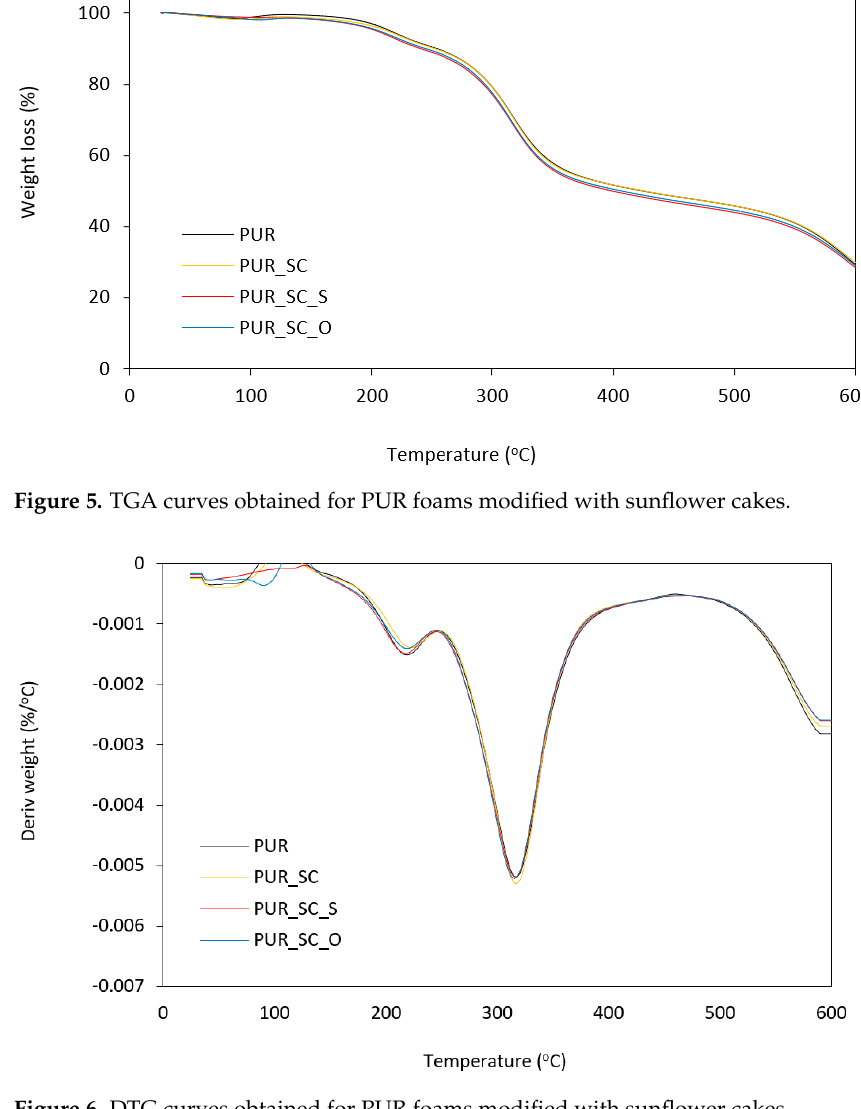
Figure 6. DTG curves obtained for PUR foams modified with sunflower cakes. Table 4. The results of TGA and DTGA